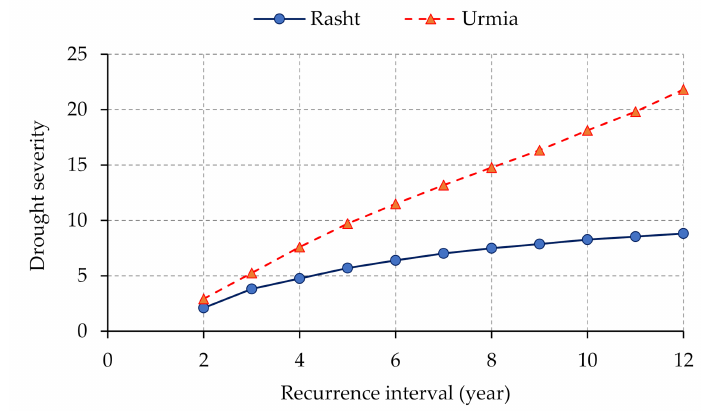
Figure 13. Corresponding drought severity with T ∨ peak =